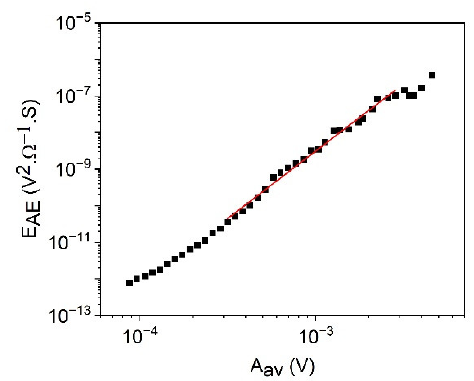
Figure 8. logE AE versus logA av plot for heating in alloy B (at B = 0).